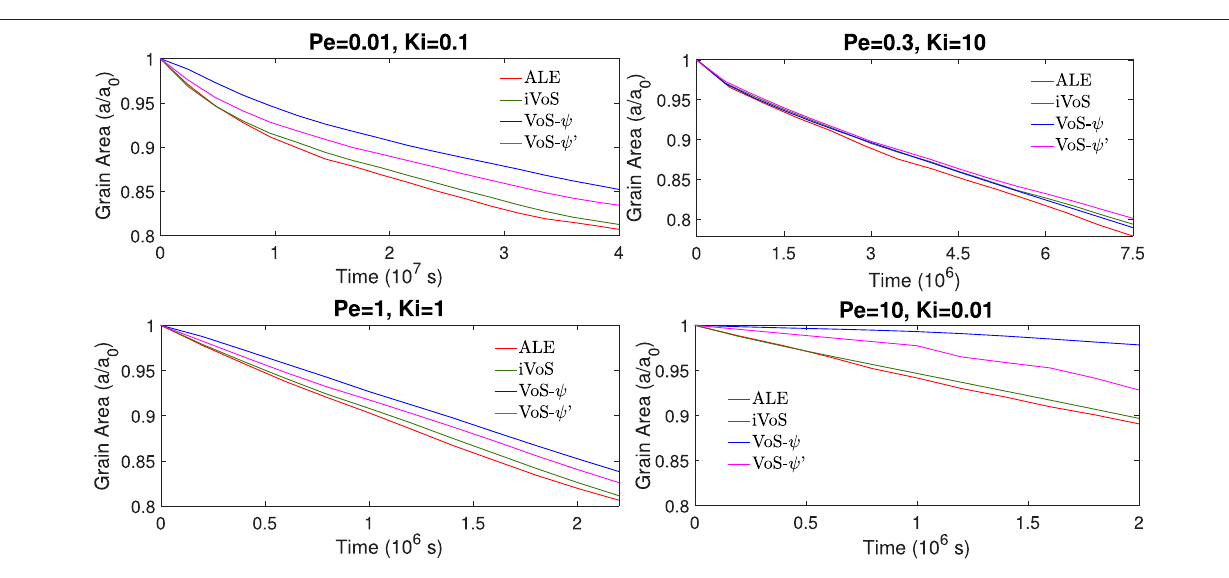
Frontiers in Earth Science |